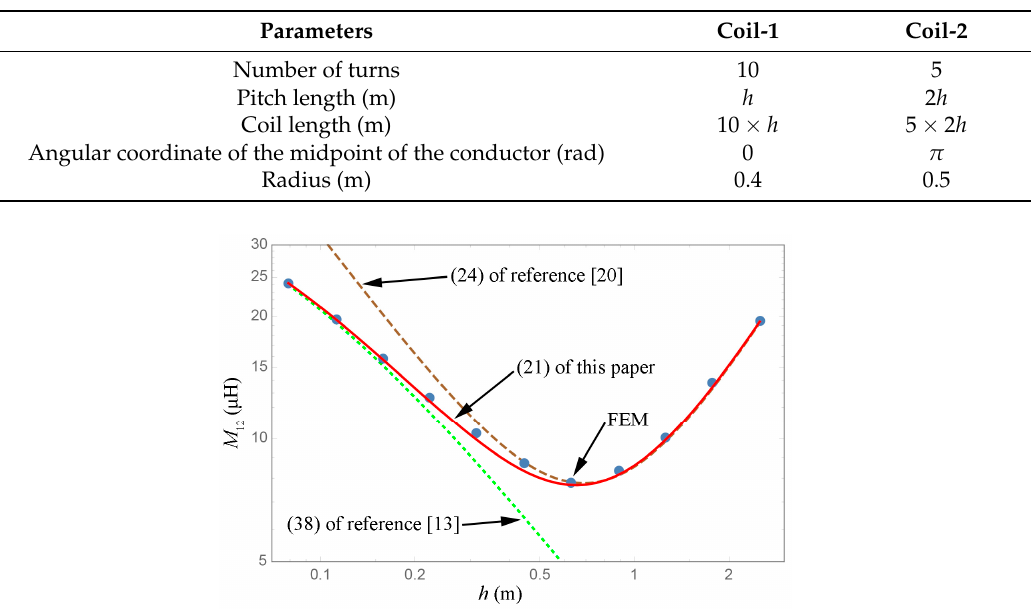
Table 5. Geometric parameters of the coils in Figure 2 (4th comparison).